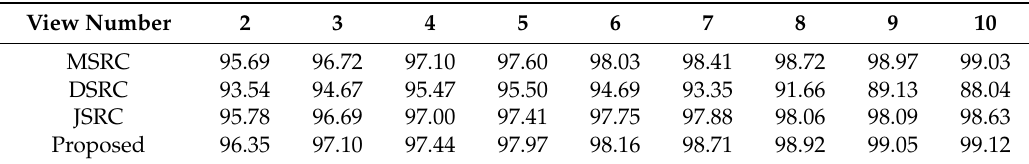
Table 5. PCCs of multi-view methods at different view numbers